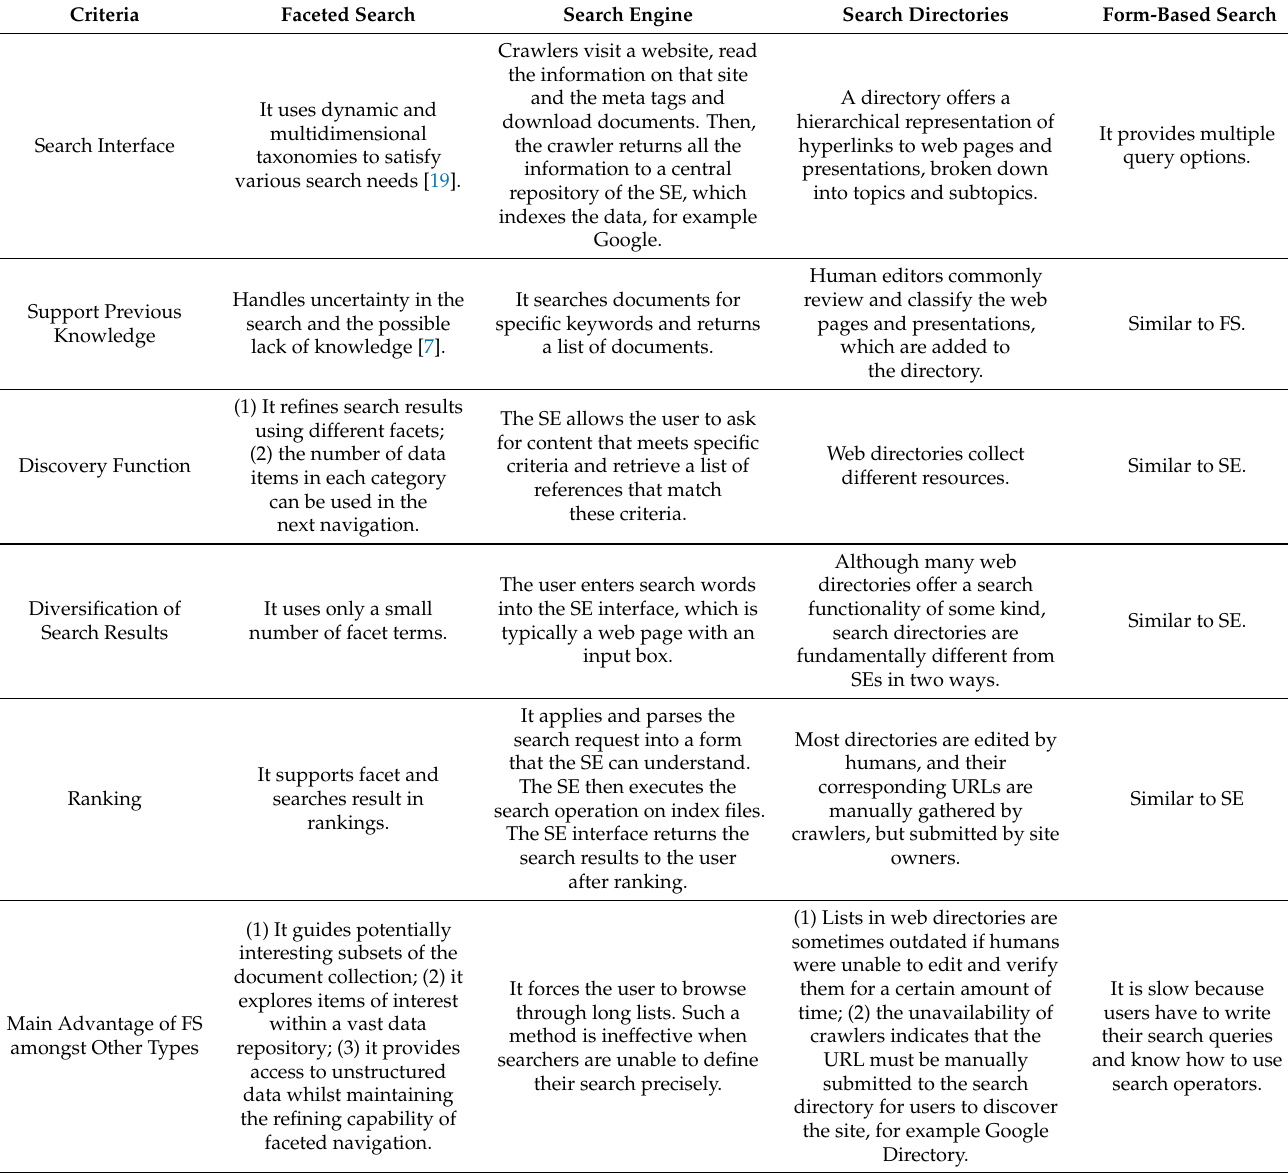
Table 1. Comparison of faceted search with other search